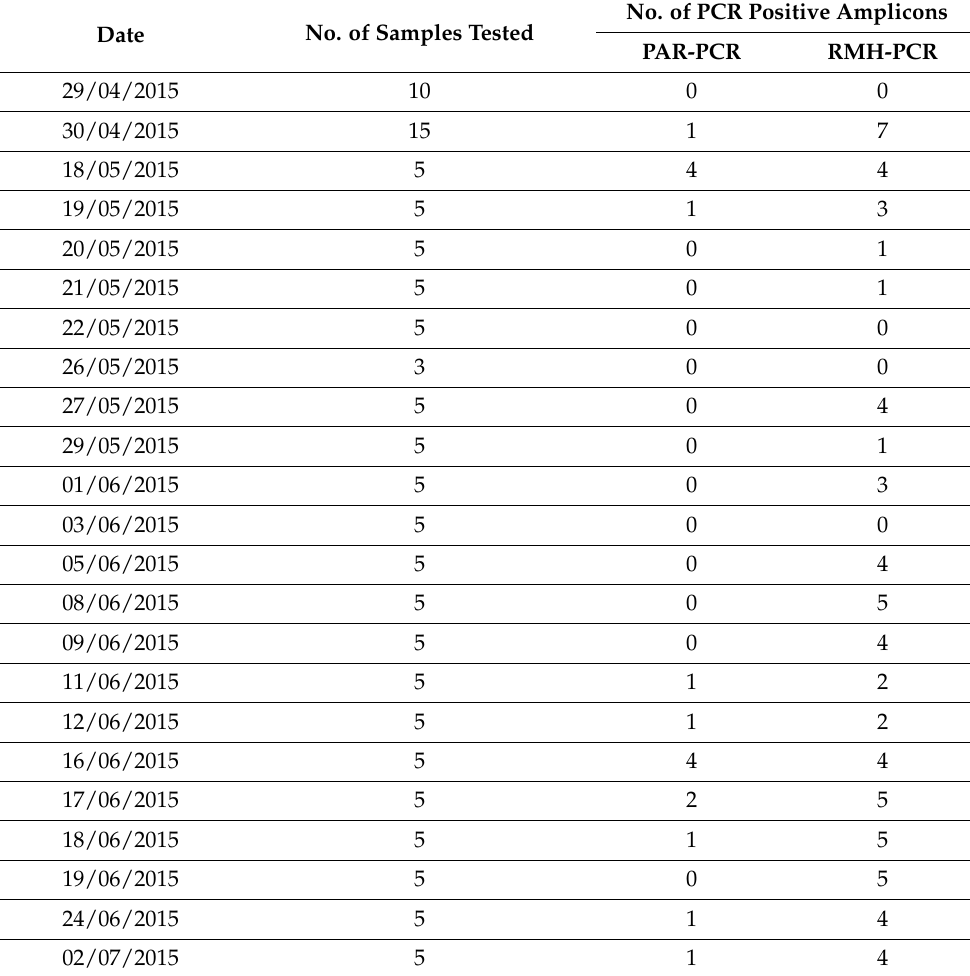
Table 1. The number of urine samples tested at each sampling time point and corresponding number of positive amplicons detected for PAR- and RMH-PCR